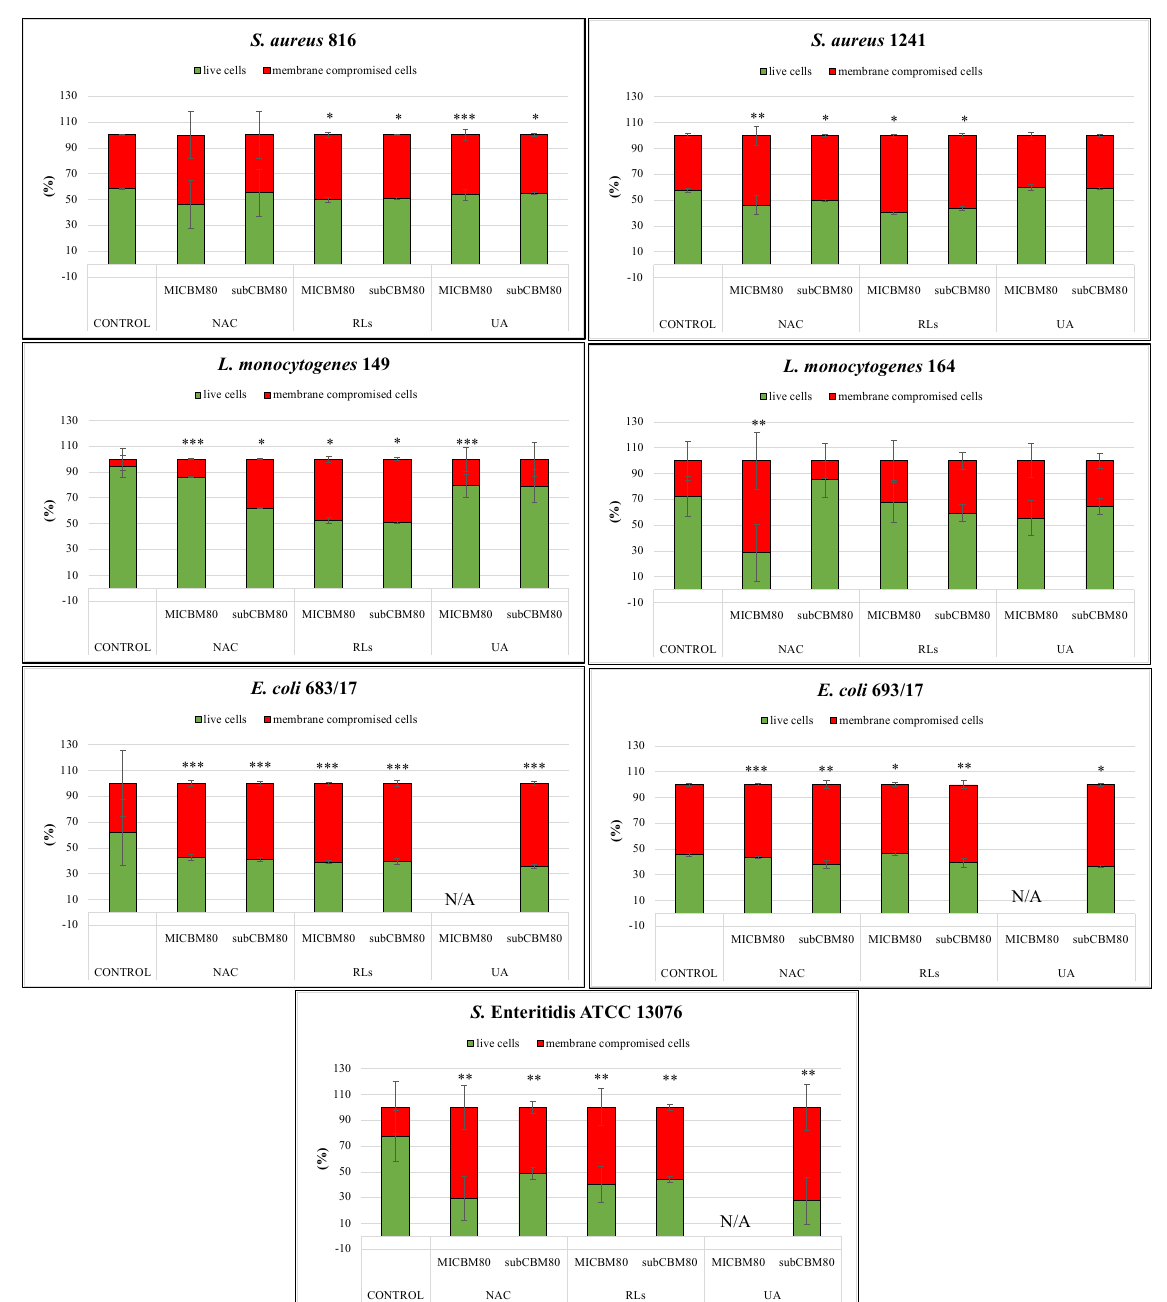
Figure 3. Biofilm Prevention: Ratios of live (green) and membrane−compromised cells (red) of individual organisms ( Staphylococcus aureus 816, 1241, Listeria monocytogenes 149, 164, E. coli 683/17, 693/17, and Salmonella Enteritidis ATCC 13076) after 24 h of treatment with N−acetyl−L−cysteine (NAC), rhamnolipids (RLs), and usnic acid (UA). Columns represent the mean and standard deviation of at least four independent technical replicates. For some strains, the minimum inhibitory and subinhibitory concentrations could not be established; thus, they were not involved in the analysis. N/A marks concentration was not applied. * marks p < 0.001, ** marks p < 0.01, *** marks p < 0.05, which are statistically significant differences in proportions of membrane−compromised cells comparing to the control.